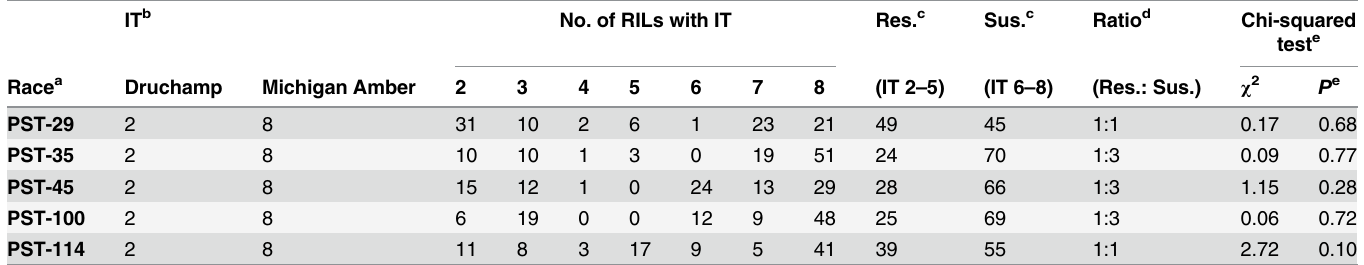
Table 1. Seedling infection types (ITs) of the parents and number of F 8 recombinant inbred lines (RILs) from the Druchamp × Michigan Amber-de- rived recombinant inbred lines (RILs) tested in the greenhouse with races of Puccinia striiformis f. sp. tritici , theoretical segregation ratios of resis- tant and susceptible lines, and χ 2 and P values of chi-squared tests for goodness of fit of the observed numbers and expected ratios. IT b